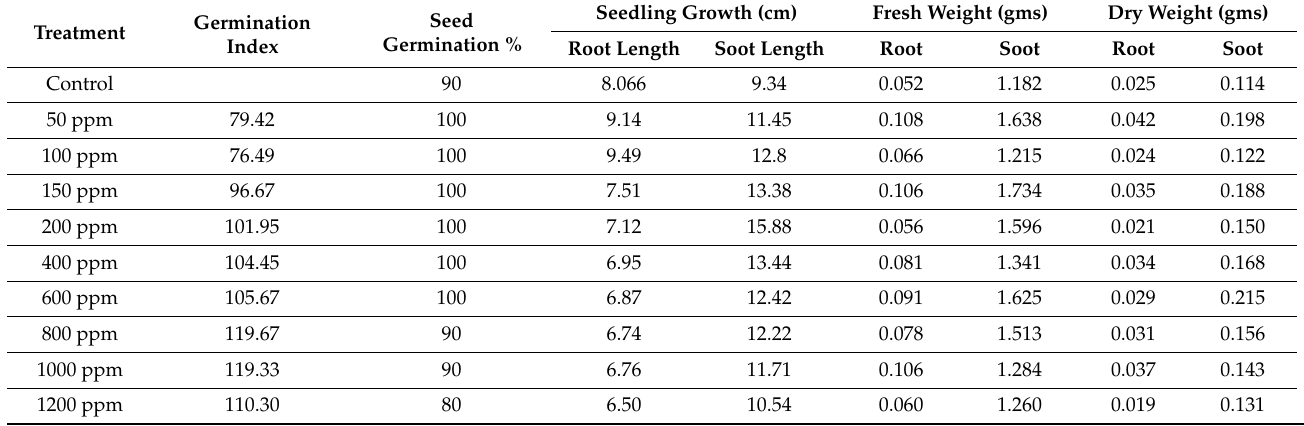
Table 2. Results for Mung bean seed.